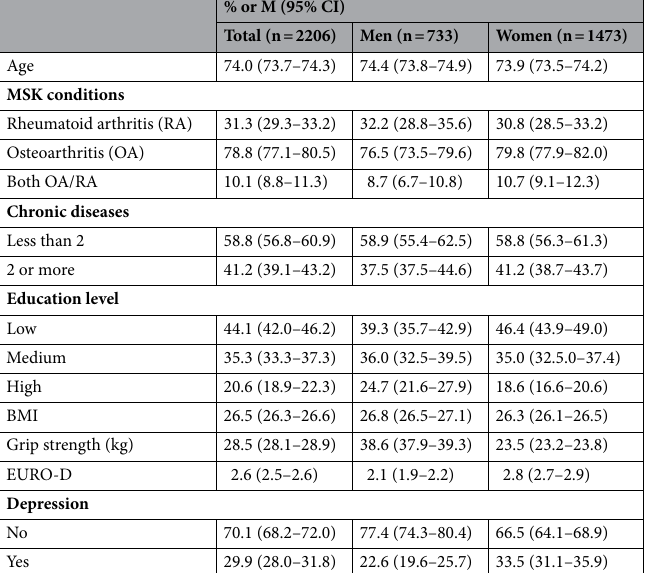
Table 1. Participant’s characteristics, M mean, CI confidence interval, BMI body mass index.